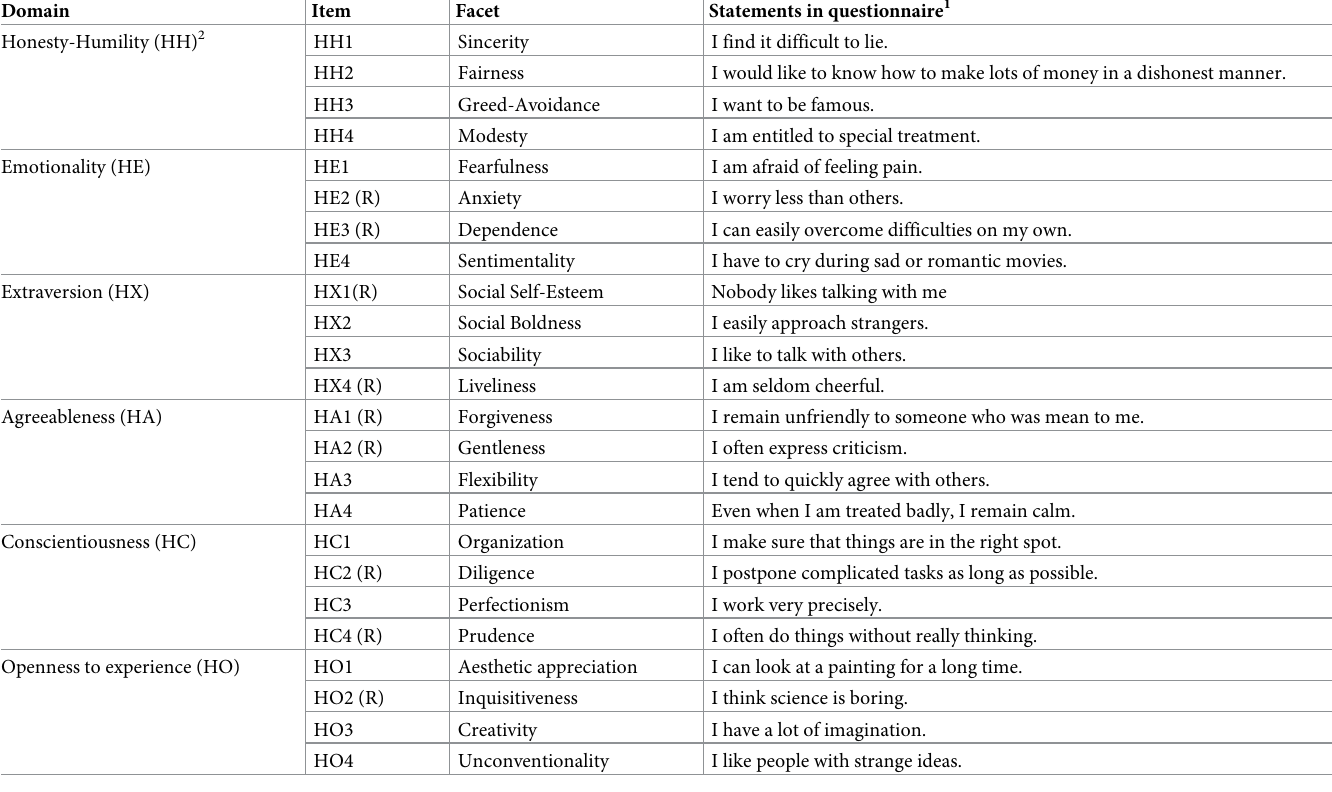
Table 1. Structure of the 24-item BHI used for personality